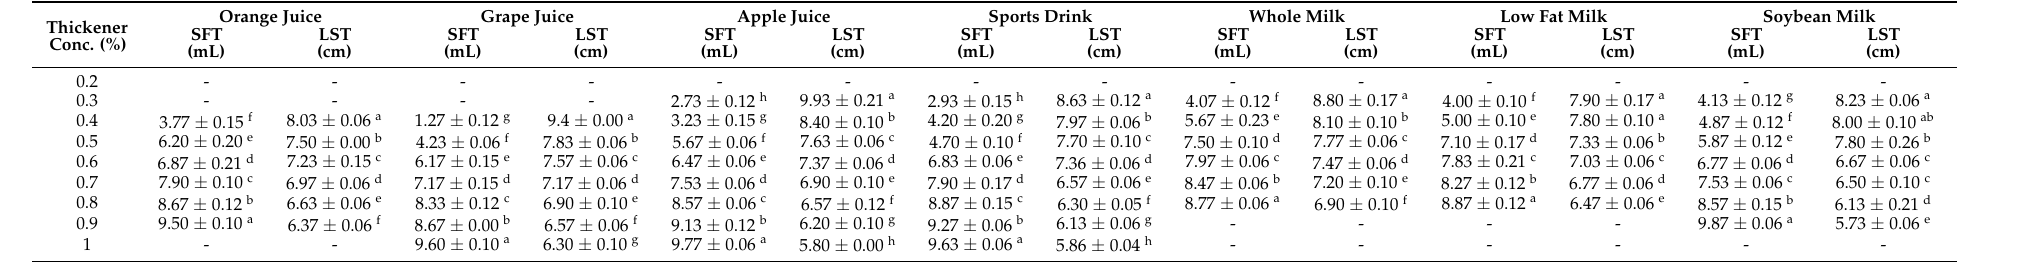
Table 3. Syringe flow test (SFT) and Line spread test (LST) measurements within nectar-thick viscosity ranges (51–350 mPa · s). Thickener Conc.